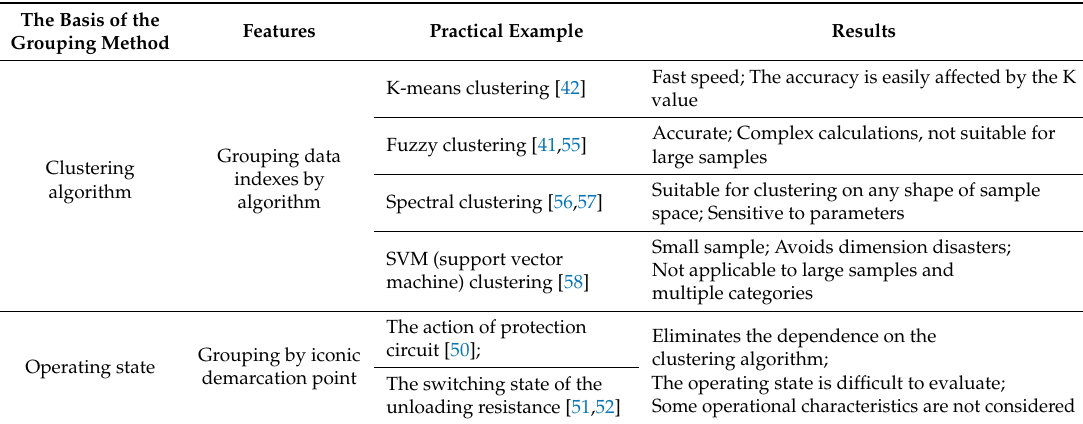
Table 5. The comparison of grouping